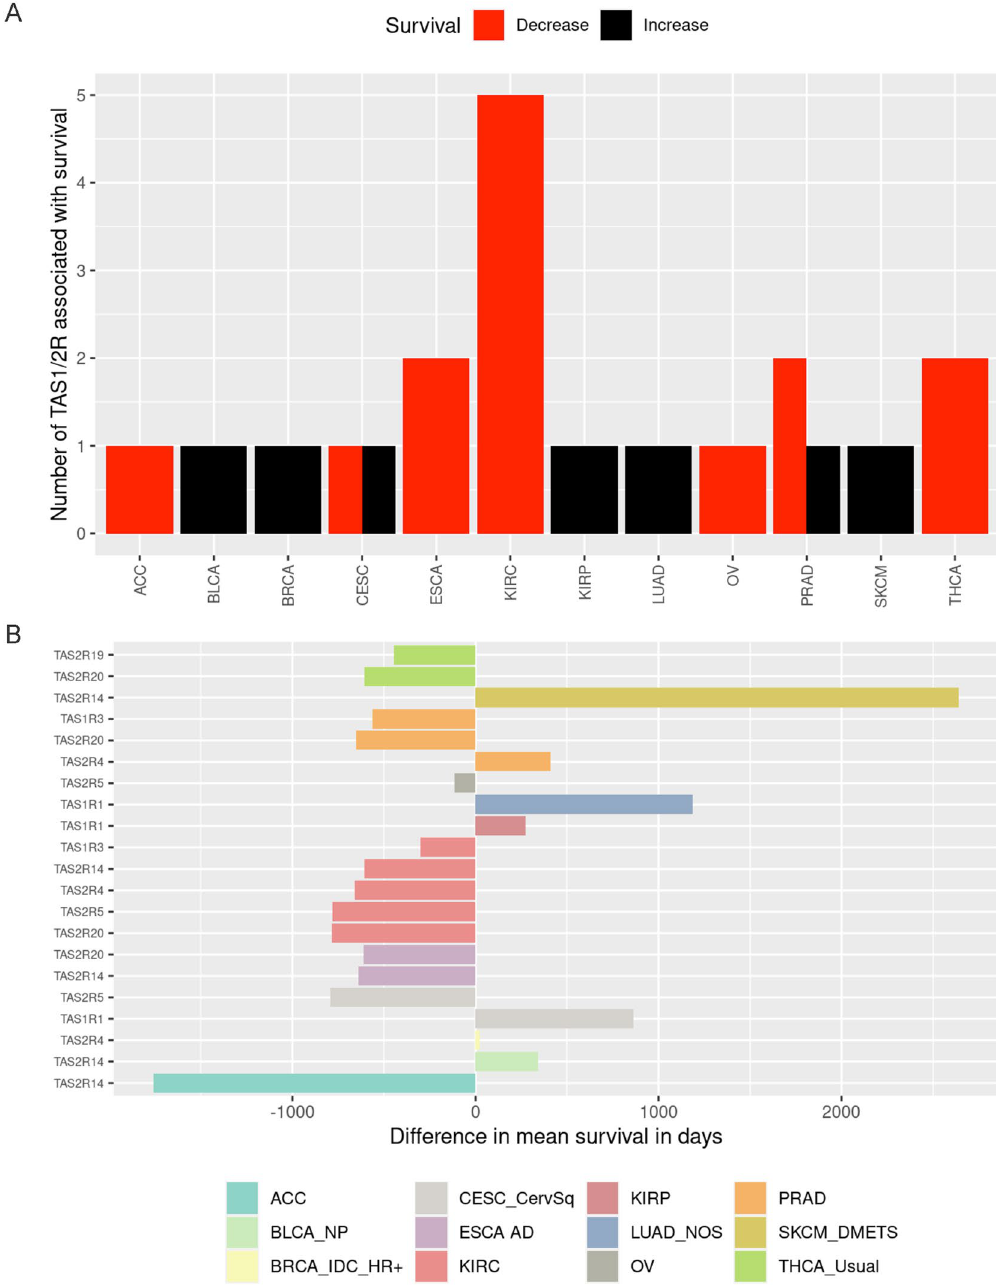
Figure 5. TAS1R and TAS2R expression is associated with survival in solid tumors. Tumor samples were divided into high and low expression groups and the difference in mean survival days was calculated for these groups for each TAS1R / TAS2R gene and tumor. ( A ) Bar graph demonstrating the number of genes significantly associated with increased (black) or decreased (red) survival in solid tumors ( p < 0.05). Non-significant associations are not shown. Negative survival difference indicates that higher gene expression corresponds to shorter survival times while positive survival difference indicates that higher gene expression corresponds to longer survival times. ( B ) Difference in mean survival in days between above-median and below-median expression groups for each TAS1R and TAS2R genes for tumors that reached significance in ( A ). Negative values imply an adverse impact on survival where patients with higher median expression survived shorter than those with lower median expression and vice versa. ACC adrenocortical cancer; BLCA_NP non-papillary bladder cancer; BRCA_IDC_HR + hormone receptor positive infiltrating ductal carcinoma; CESC_CervSq cervical esophageal squamous cell carcinoma; CPM counts per million; ESCA_AD esophageal adenocarcinoma; KIRC kidney clear cell carcinoma; KIRP kidney papillary cell carcinoma; LUAD_NOS lung adenocarcinoma not otherwise specified; OV ovarian cancer; PRAD prostate adenocarcinoma; SKCM_DistantMets distantly metastatic skin melanoma; THCA_usual thyroid cancer usual